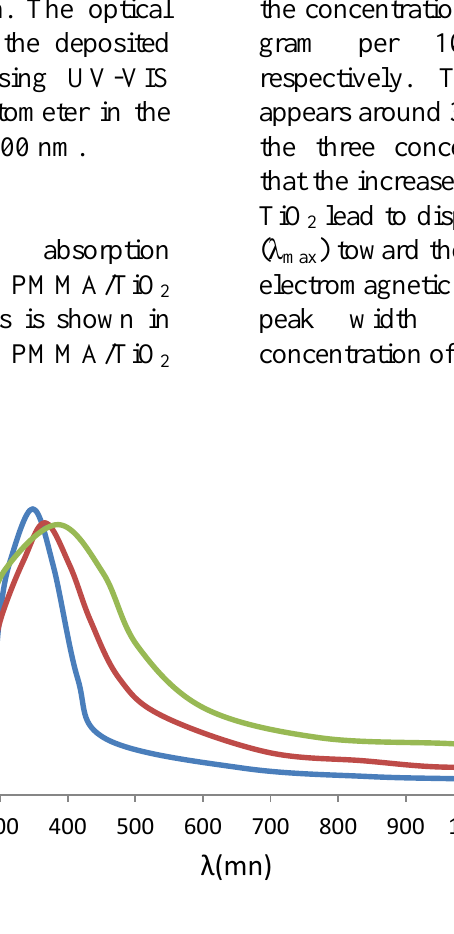
nanocomposite thin 2